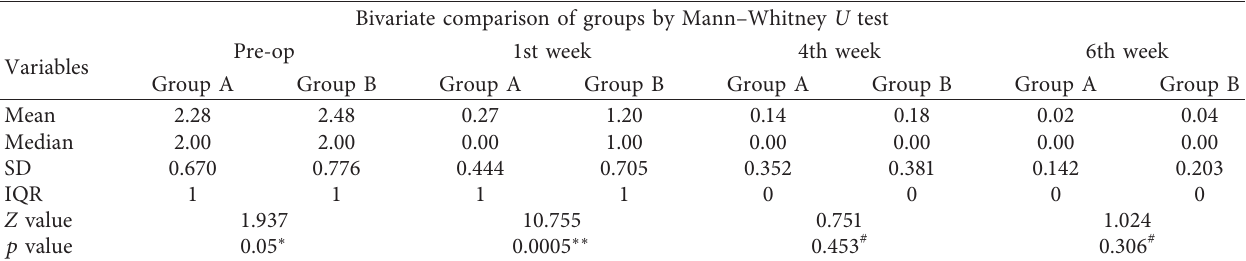
Table 5: Comparative analysis of pain score in group A and group B patients in pre-op and postoperative period.